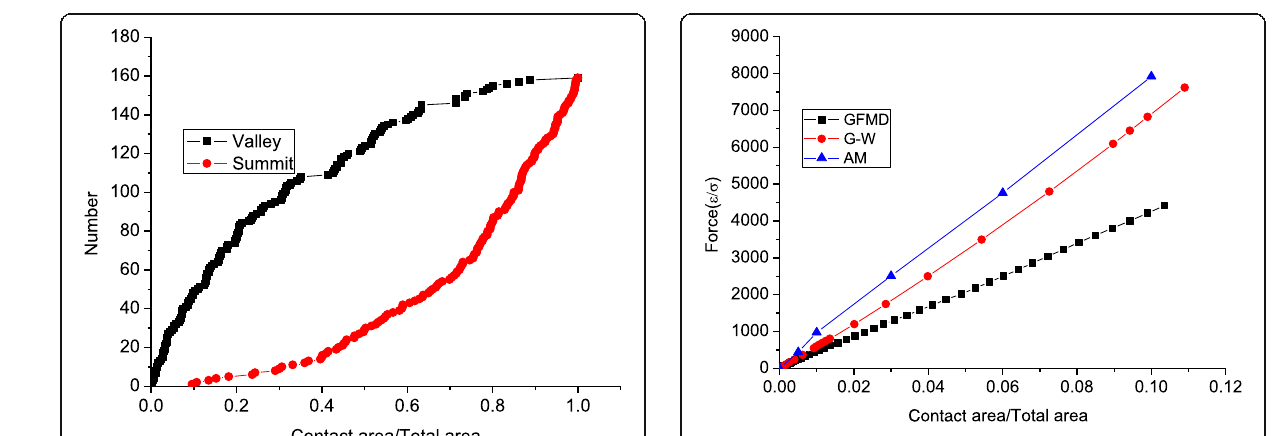
Fig. 9 Relation of the contact area and load for different